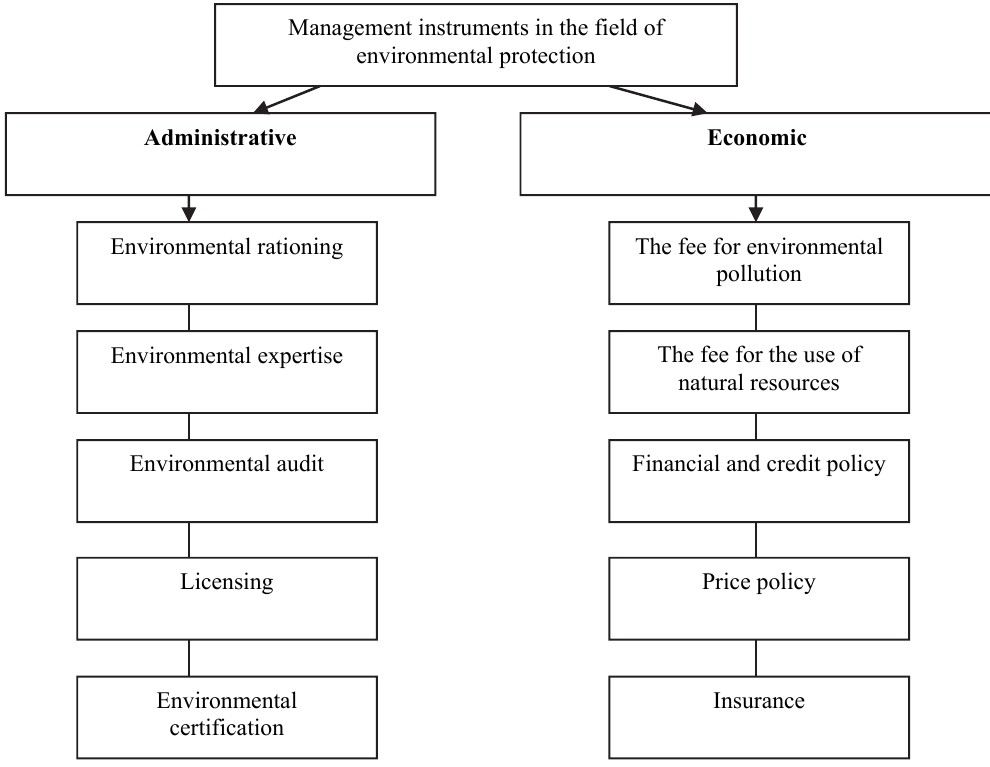
Fig. 1. The mechanisms of environmental management based on the direction of stimulating public-private